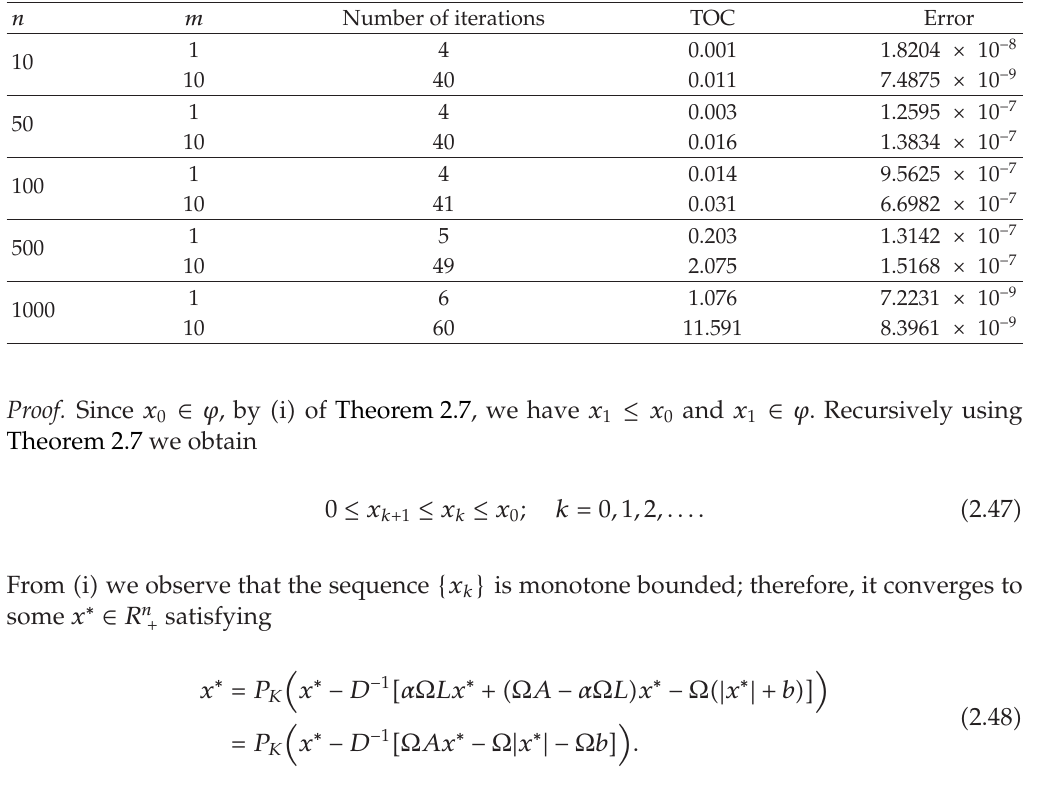
Table 1: Computational